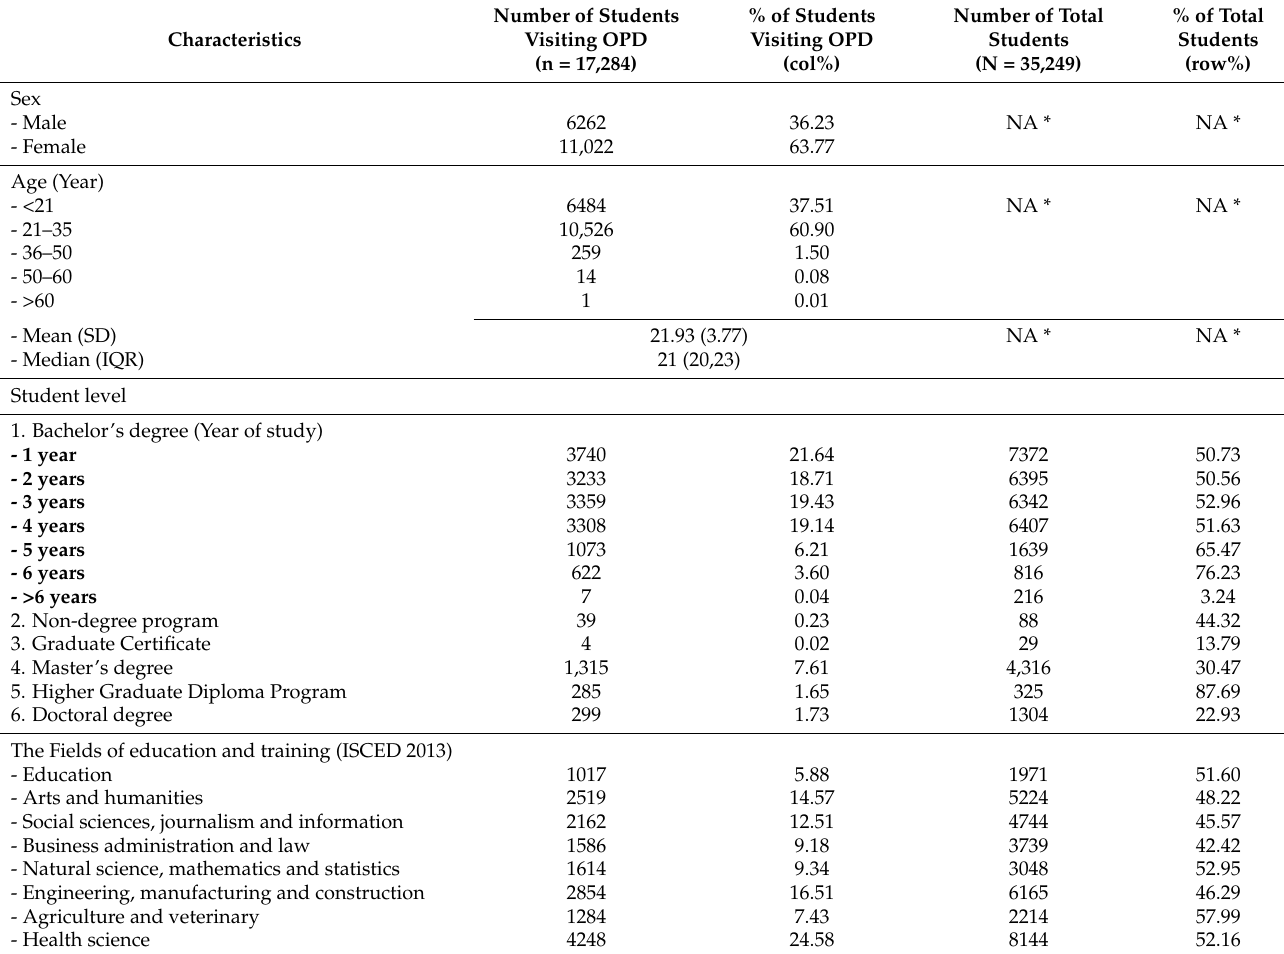
Table 2. Socio-demographic characteristics of CMU Students utilizing OPD services (n = 17,284 students).